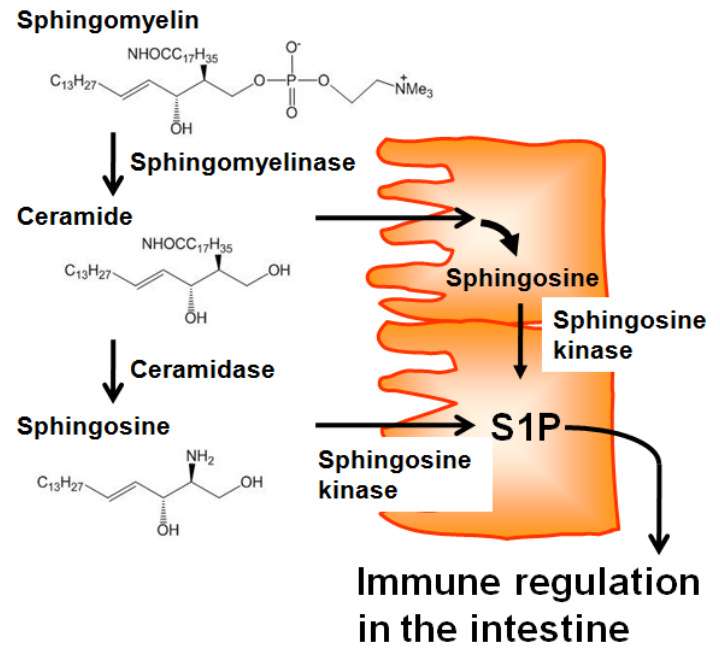
Figure 1. Dietary sphingolipids in epithelial-cell S1P production. Dietary sphingomyelin is degraded into ceramide and subsequently sphingosine by alkaline sphingomyelinase and ceramidase, respectively, which are expressed on the apical membranes of epithelial cells. In the epithelial cells, absorbed ceramide is metabolized into sphingosine. Together with absorbed sphingosine, sphingosine kinase metabolizes sphingosine into S1P, which